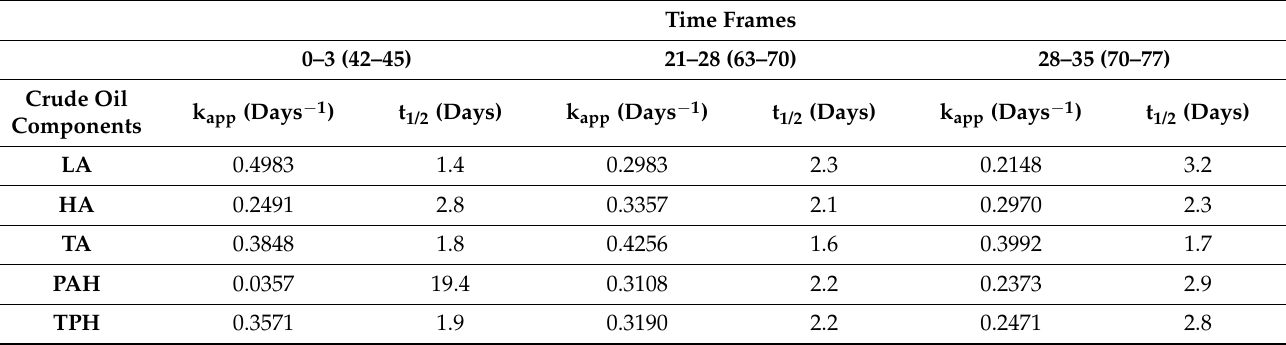
Table 2. Initial rates and half-life times for light alkanes (C 14 –C 25 ) (LA); heavy alkanes (C 26 –C 35 ) (HA); total alkanes (C 14 –C 25 ); polycyclic aromatic hydrocarbons (PAH); and total petroleum hydrocarbon (TPH). The data refer to the GC-MS detected components of the crude oil for the OIL + D treatment of the time-series